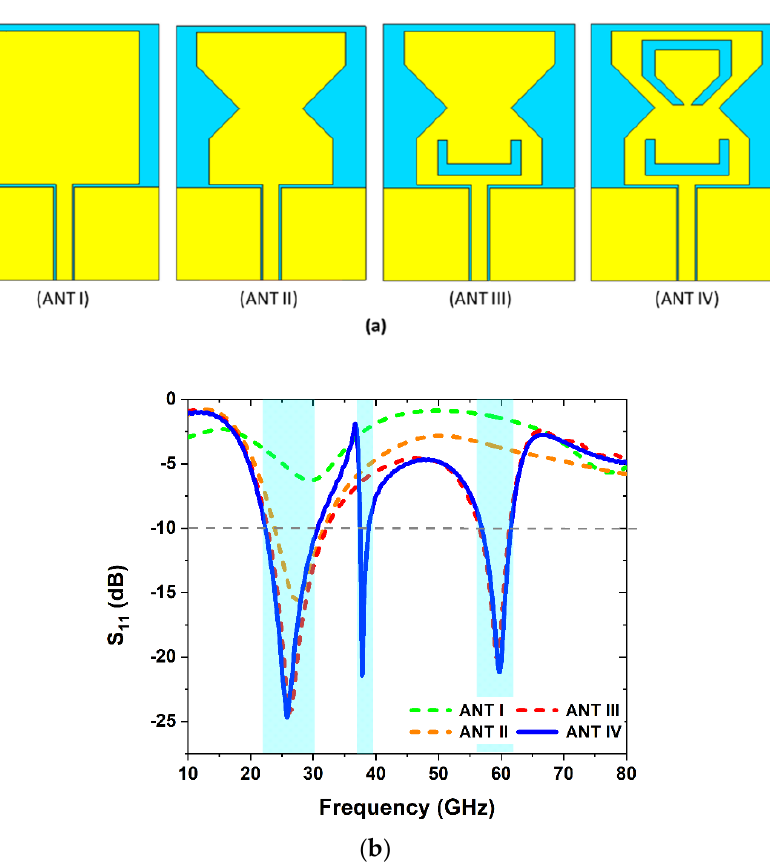
Figure 1. ( a ) Proposed design steps of the antenna. ( b ) Antenna return loss comparisons at various phases of design.